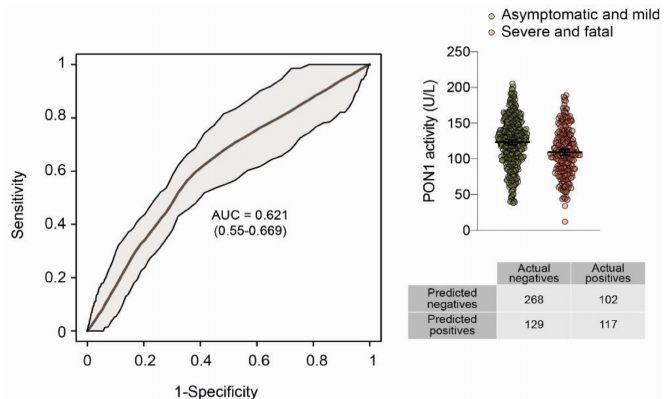
Figure 2. Serum paraoxonase-1 (PON1) and Receiver Operating Characteristics (ROC) curves comparing asymptomatic and mild versus severe and fatal COVID-19-positive patients. AUC: Area under the curve.